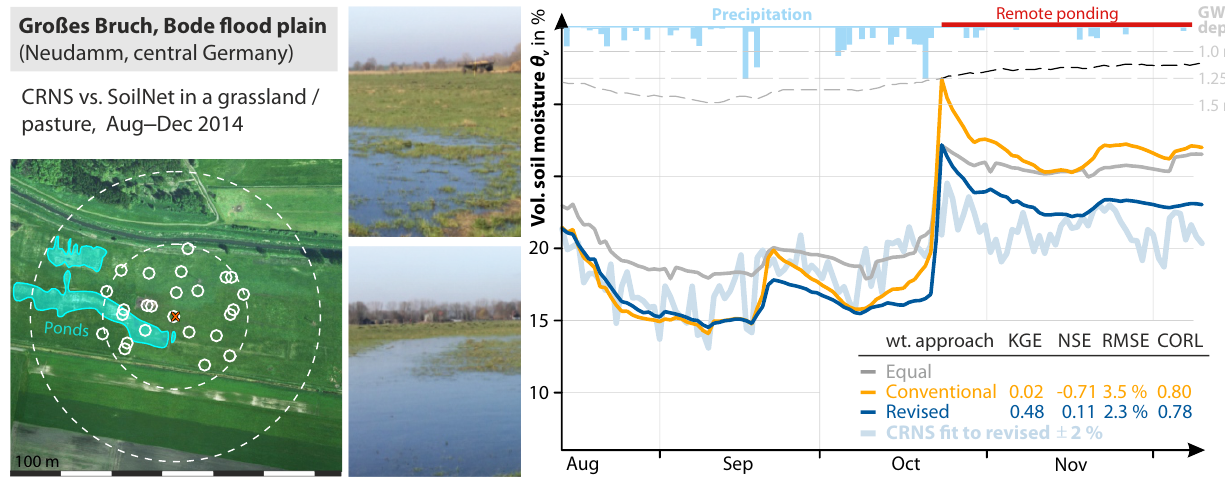
Figure 8. Time series of soil moisture measured in a pasture/floodplain – Grosses Bruch . The rain events in mid-October 2014 lead to a rise in the groundwater level and ponding in regions that are several tens of meters away from the neutron sensor. In that period, equal and conventional weighting leads to overestimation of apparent soil moisture near the CRNS probe, to which the detector has higher sensitivity than to the remote